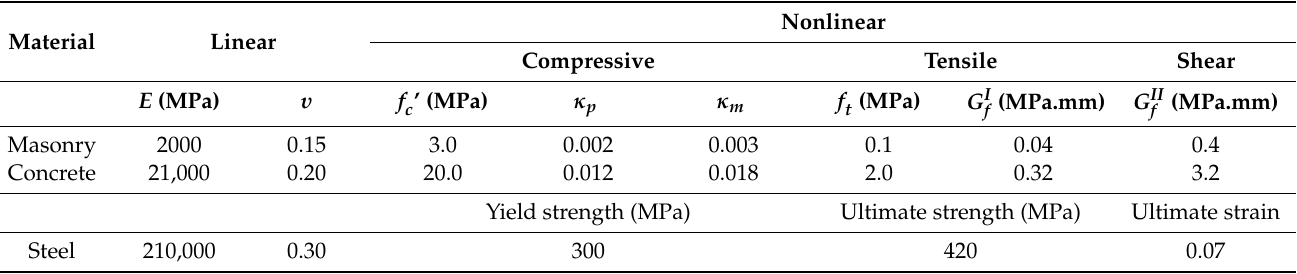
Table 2. Mechanical properties of material